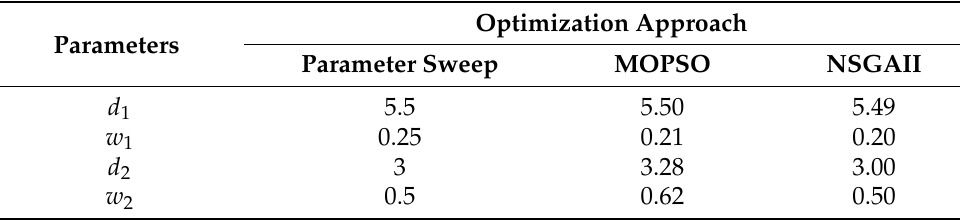
Table 3. FSS structure parameters for different optimization approaches (unit: mm).